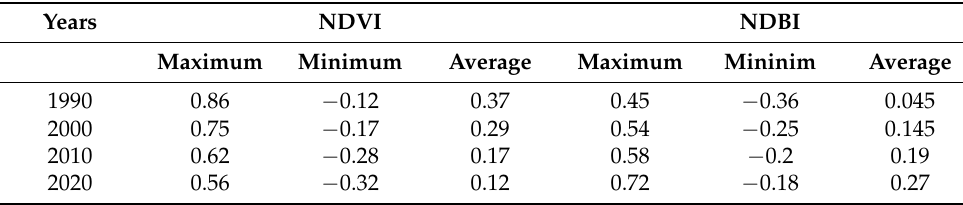
Table 5. Summary of maximum and minimum values of NDVI and